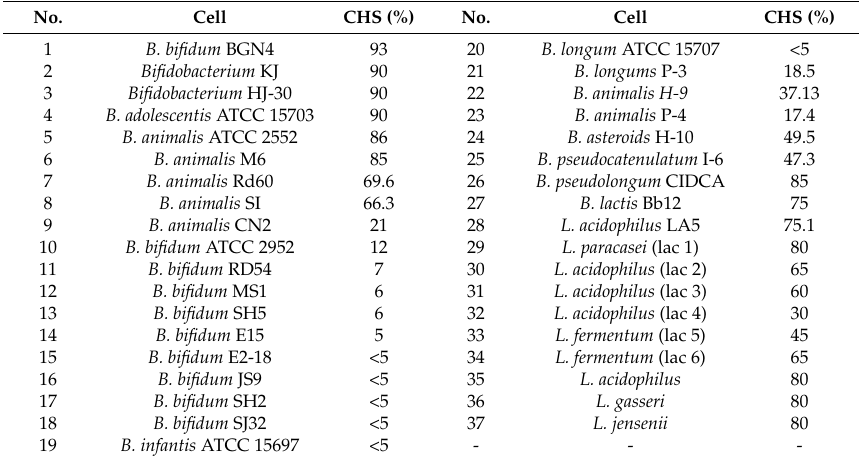
Table 1. Microbial hydrophobicity of the cellular surface (CHS) among reference strains. No. Cell CHS (%) No. Cell CHS